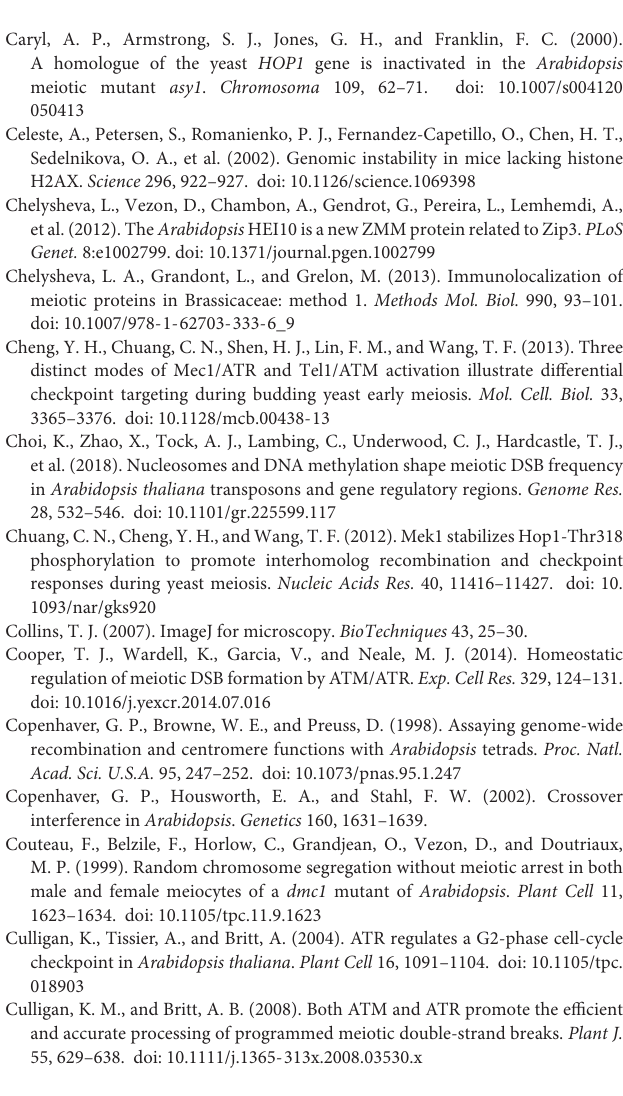
TABLE S6 | Numbers of counted chiasmata in each image. TABLE S7 | Number of cells counted in each type of